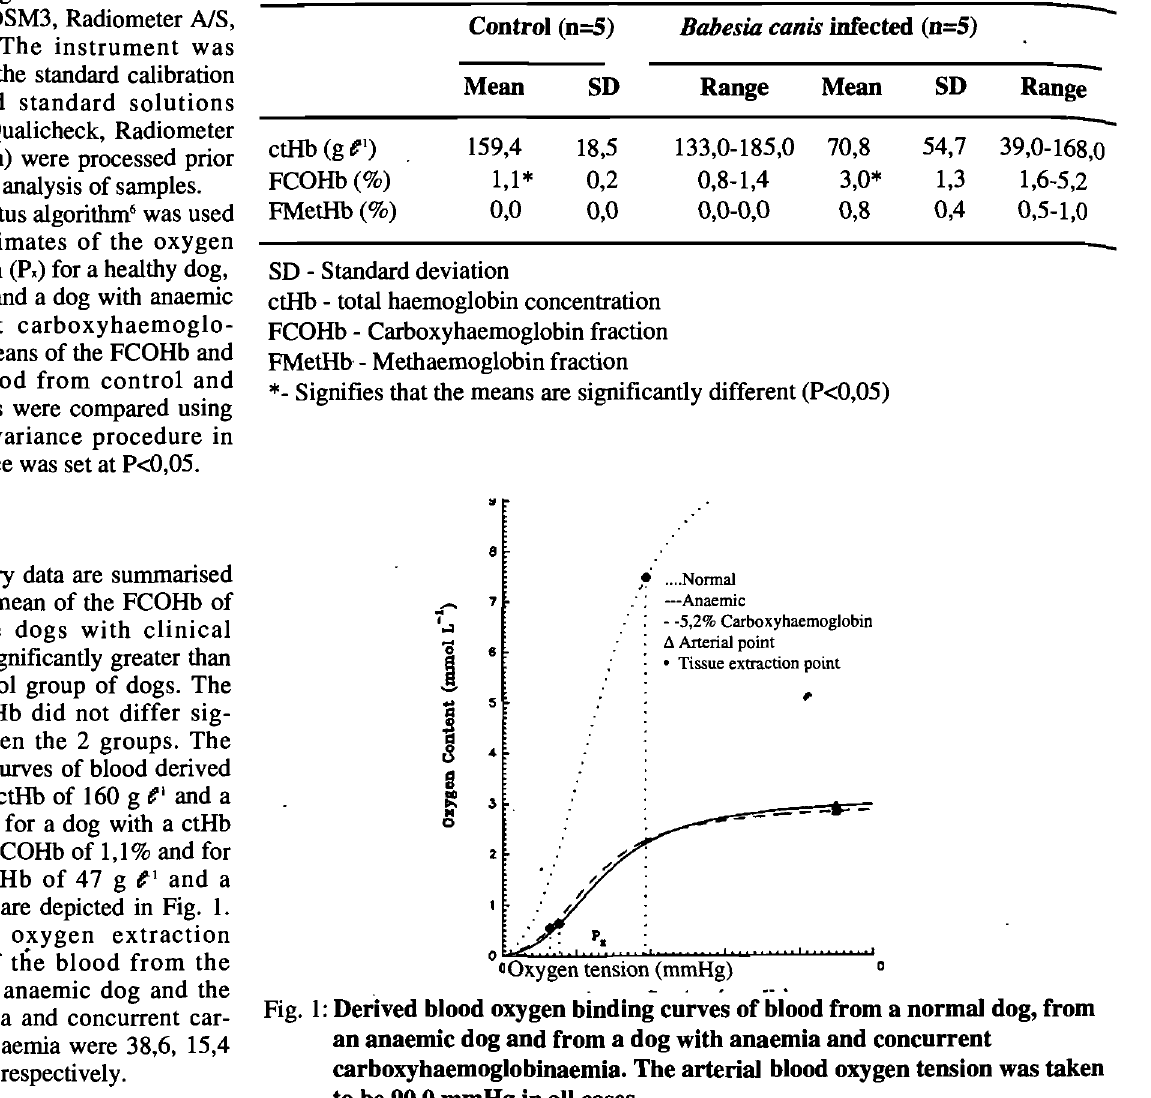
I Fig. 1: Derived blood oxygen binding curves of blood from a normal dog, from an anaemic dog and from a dog with anaemia and concurrent carboxyhaemoglobinaemia. The arterial blood oxygen tension was taken to be 90,0 mmHg in all